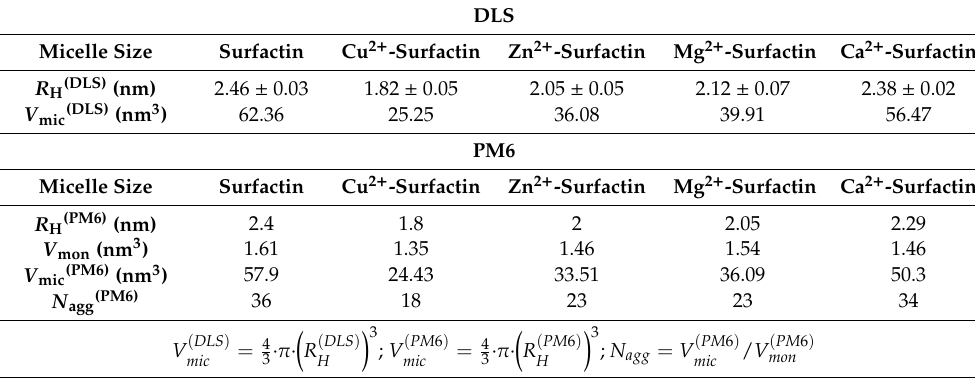
Table 1. Selected properties of the micellar systems studied. Experimental results represent the mean of 9 replicates ± SD.